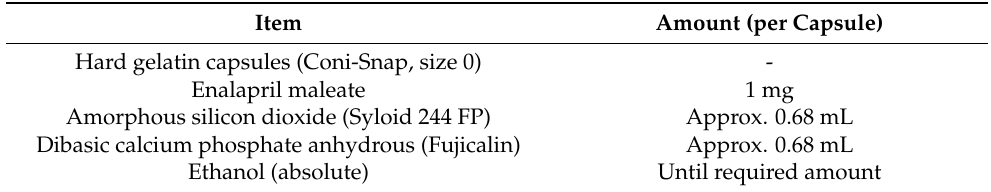
Table 1. Enalapril maleate capsule formulation. Item Amount (per Capsule) Hard gelatin capsules (Coni-Snap, size 0)